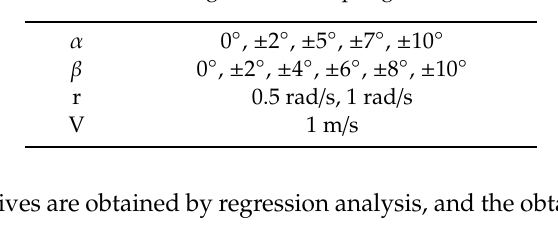
Table 10. Solving cases of coupling derivatives.